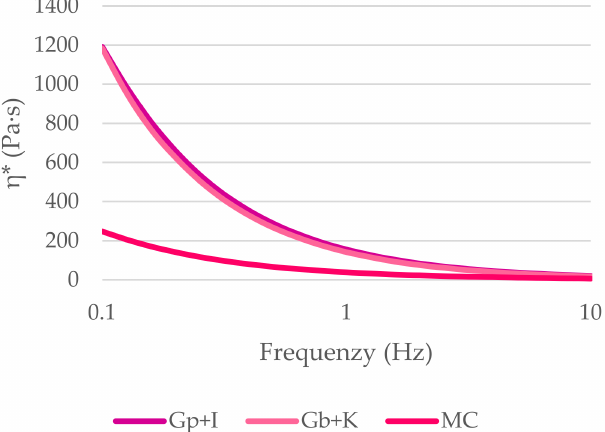
Figure 3. Apparent viscosity ( η *(Pa · s)) versus frequency (Hz) (Gp + I: porcine gelatin plus iota carrageenan; Gb + K: bovine gelatin plus kappa carrageenan; MC: methylcellulose).